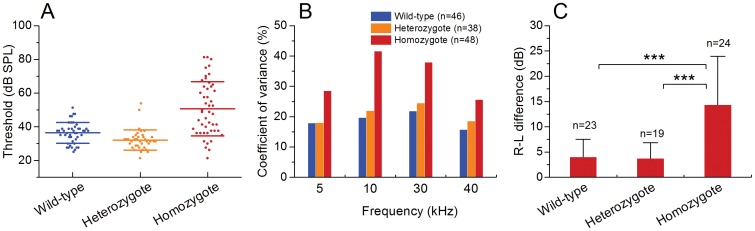
Prestin-CreERT2 knockin homozygous mice exhibit large inter- and intra-subject variation in ABR thresholds.
A A scatter plot shows the distribution of the ABR thresholds of individual ears in the Prestin-CreERT2 mice (+/+ and +/-) and the wild-type mice. One dot represents the average threshold of one ear calculated from the four tested frequencies. Notice that the ABR thresholds of the homozygous mice are more dispersedly distributed, from 21 to 81 dB SPL. By contrast, the thresholds of the heterozygous mice and the wild-type mice are much less diverse (25–51 dB for the wild-type mice and 21–54 dB for the heterozygous mice). The three lines in each group indicate the mean and ± standard deviation. B Comparison of the values of coefficient of variation among the three groups of mice. Homozygous mice display relatively larger values compared with those of the heterozygous and wild-type mice for all four tested frequencies. C Comparison of the levels of the two ear differences (the right ear vs. the left ear of the same animal) in the average of ABR thresholds of the four tested frequencies among the three groups of mice. The threshold differences between the two ears in the homozygous mice is significantly greater than those observed for the heterozygous mice or the wild-type mice (One-way ANOVA, F2,63 = 20.52, P<0.001; *** indicates P<0.001 tested by Tukey test). n: the number of the animals used for each group.